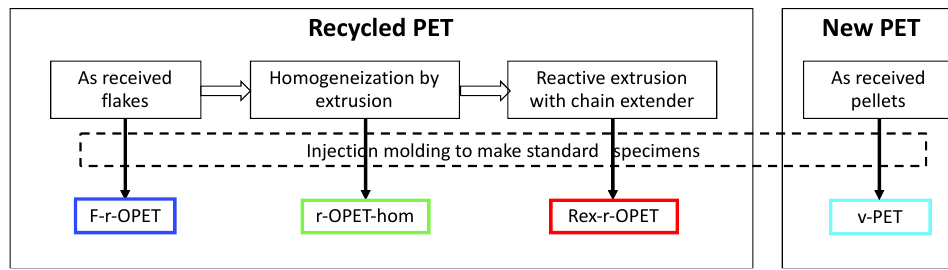
Figure 3. Types of PET materials used in this study.